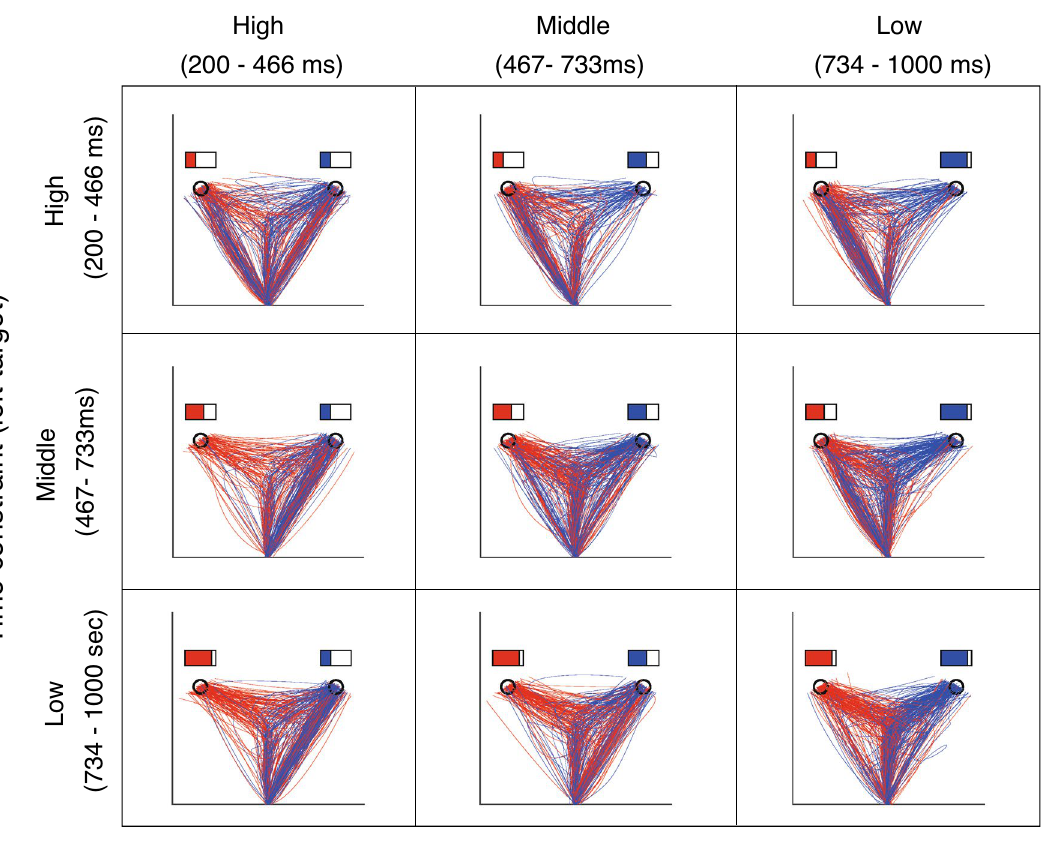
Figure 2. Movement trajectories according to combinations of the time constraints. The movement trajectories according to the time constraint of all participants in the double-target condition are shown. The color is based on the final target (red: final target is left, blue: final target is right). This figure confirmed that the trajectories of the participants’ movements are modulated according to the combination of time constraints. For combinations of equivalent time constraints, the trajectories seemed to be bilaterally symmetrical. On the other hand, in situations with different time constraints, the frequency of the initial movement to the target with shorter time constraints seemed to be